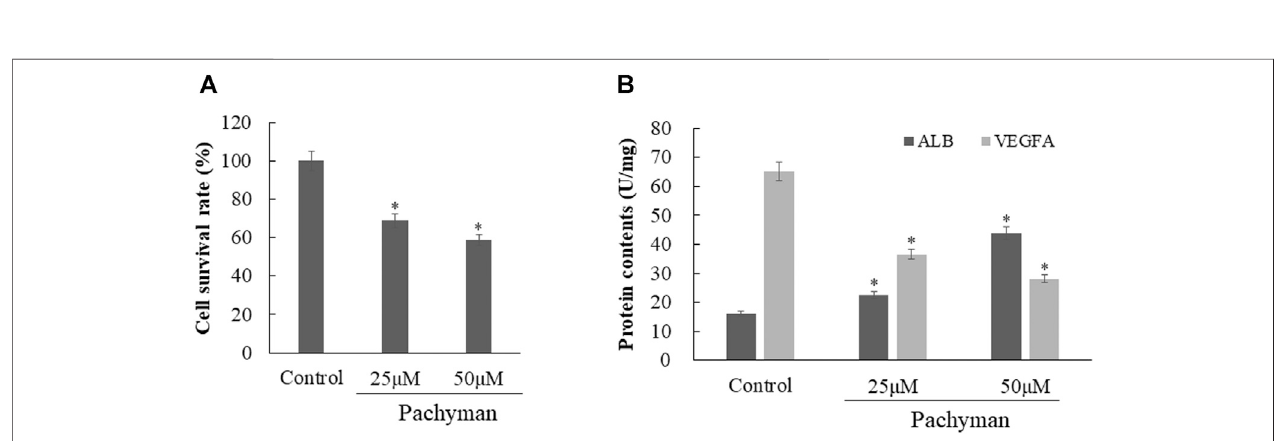
FIGURE 9 | Validated data in vitro with Pachyman-treated liver cancer cells according to molecular docking fi ndings, as shown in cell proliferation test (A) , target protein determination (B) .